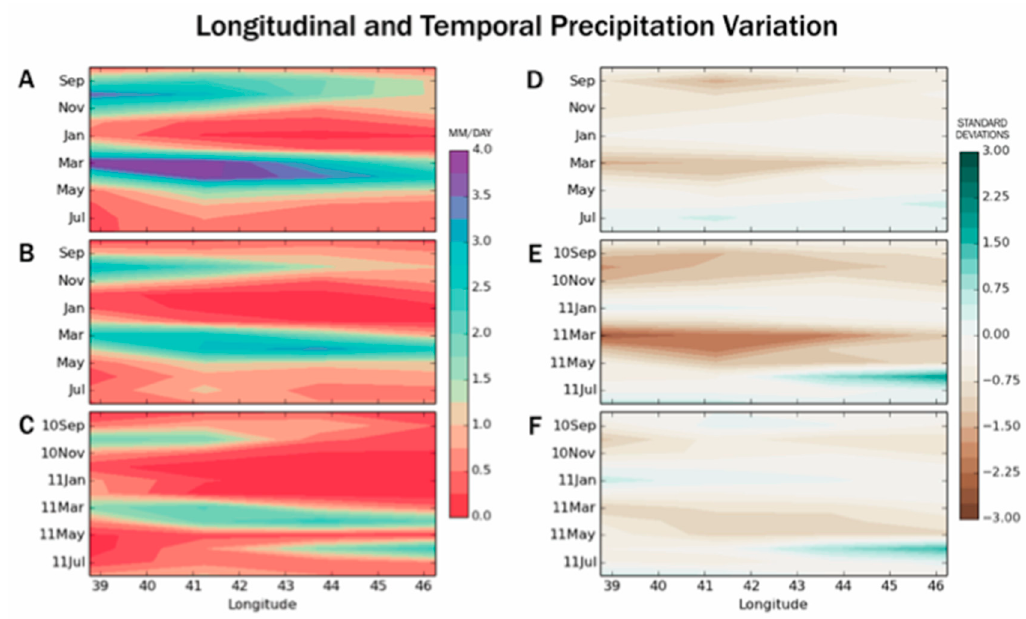
Figure 6. Similar to Figure 5, but the anomaly was averaged along the latitude between 1.5°S and 4°N.